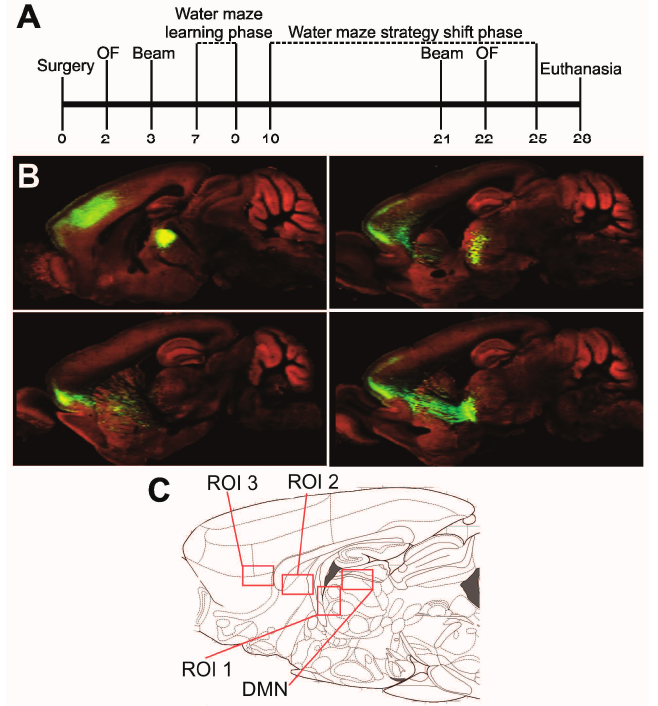
Figure 1. Experimental timeline and regions of interest. ( A ) Timeline demonstrates sequence of experimental procedures; ( B ) Dorsomedial thalamic nucleus (DMN) tracing in sagittal sections from lateral to medial reveals the connectivity between the mouse DMN and prefrontal cortex. Image credit: Allen Institute for Brain Science [23]; ( C ) The DMN and the three regions identified as regions of interest (ROIs) are marked in a schematic of a sagittal rat brain section at approximately 0.4 mm lateral to bregma (modified from Paxinos and Watson, 1998). ROI 1 = Periventricular white matter. ROI 2 = Striatal region of thalamocortical axon passage. ROI 3 = Deep layers of the frontal (pre-/infralimbic)